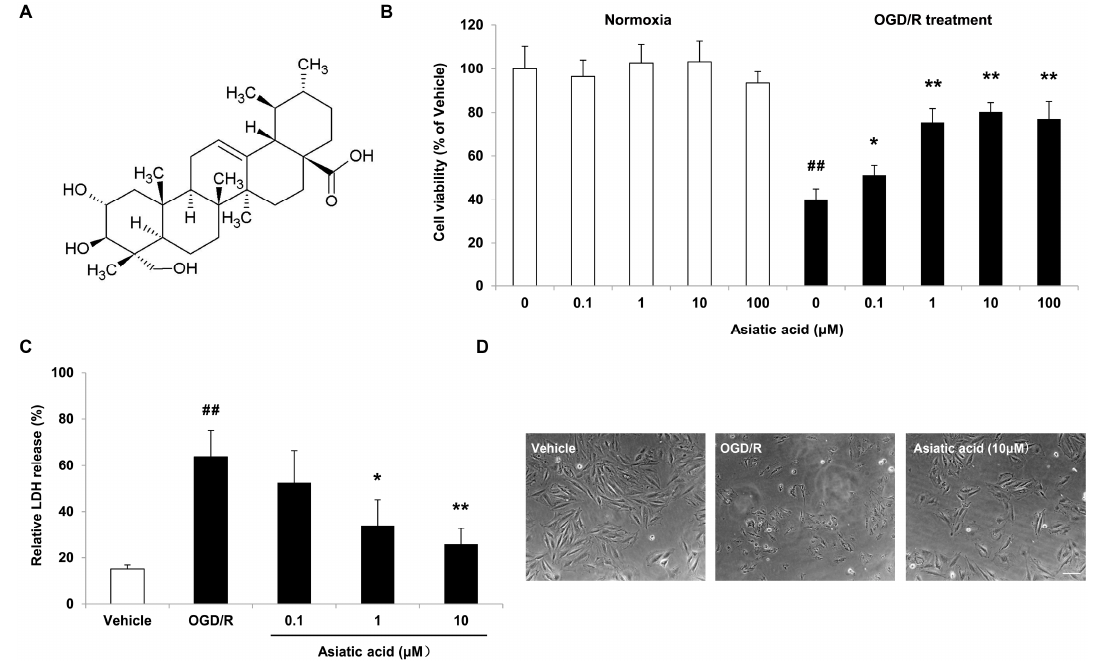
Figure 1. Asiatic acid attenuates oxygen-glucose deprivation/reoxygenation (OGD/R)-induced cell death in H9c2 rat cardiomyocytes. ( A ) Chemical structure of asiatic acid; ( B ) The MTT (3-(4,5-dimethylthiazol- 2-yl)-2,5-diphenyltetrazolium bromide) tetrazolium reduction assay for cell viability under normoxia or subjected to OGD/R; ( C ) Determination of the relative LDH release after OGD/R exposure; ( D ) Morphology alterations after OGD/R injury under an inverted phase microscope. ## p < 0.01 vs. the vehicle group; * p < 0.05, ** p < 0.01 vs. the OGD/R group. Scale bar, 100 μ m.